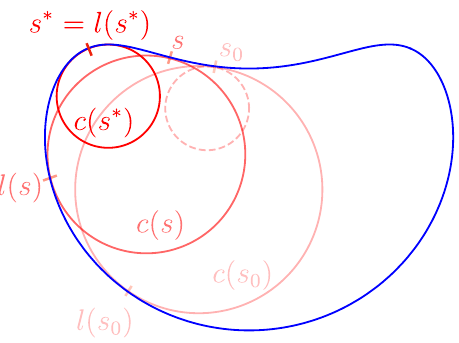
Figure 9 . We show the procedure outlined in the text for finding an osculating circle c ( s ∗ ) inside a given